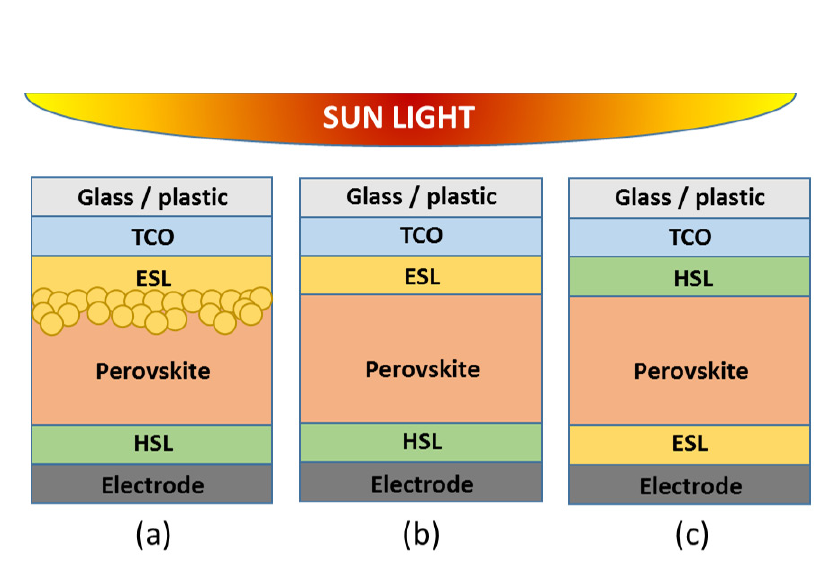
Fig. 13. – Schematics of the different perovskite solar cell architectures (a) mesoscopic n-i-p cell, (b) planar n-i-p cell, (c) p-i-n cell. HSL can be polymers (PTAA, P3HT), molecules